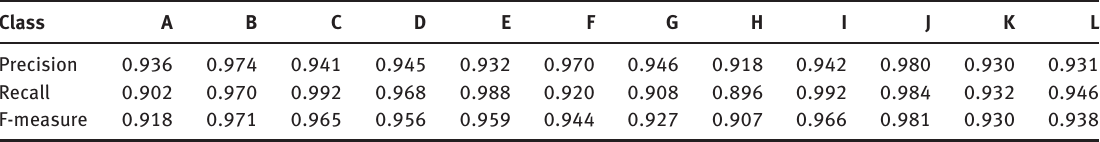
Table 3: Detailed Performance Measures of the Individual Script Classes for the Best Performing Scheme at Word Level. Class